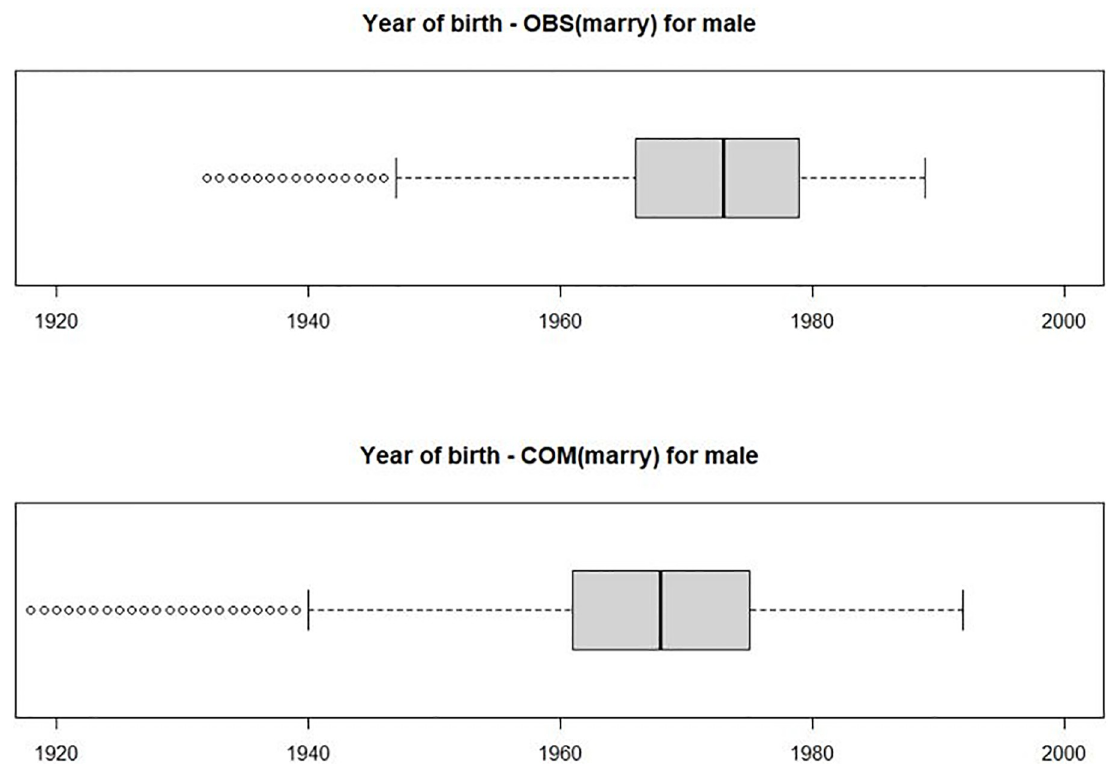
Fig 3. Box plot of year of birth by observed and completed group for marital status (male). Note: OBS: observed data, COM: complete data which combines observed and imputed datasets.